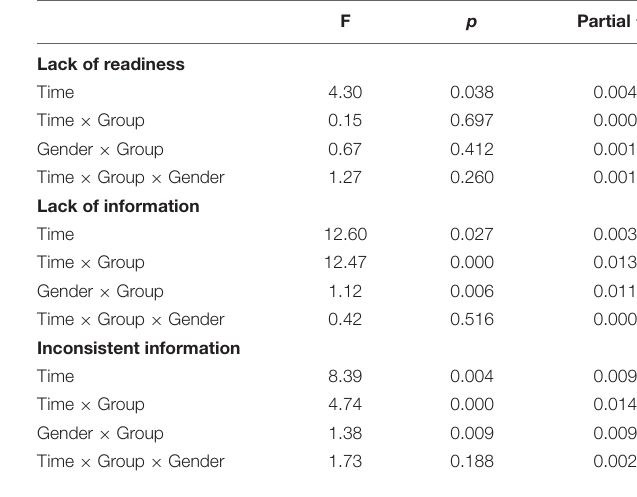
TABLE 4 | The effects of the intervention on career decision-making difficulties and the moderating effect of